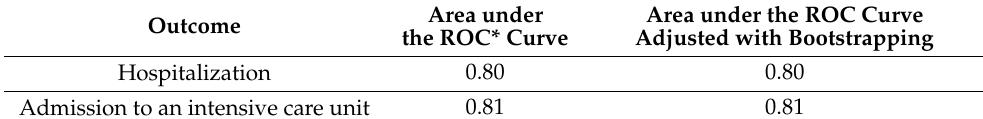
Table A5. Predictive validity of the variables from the reduced model fitted for the secondary outcomes.